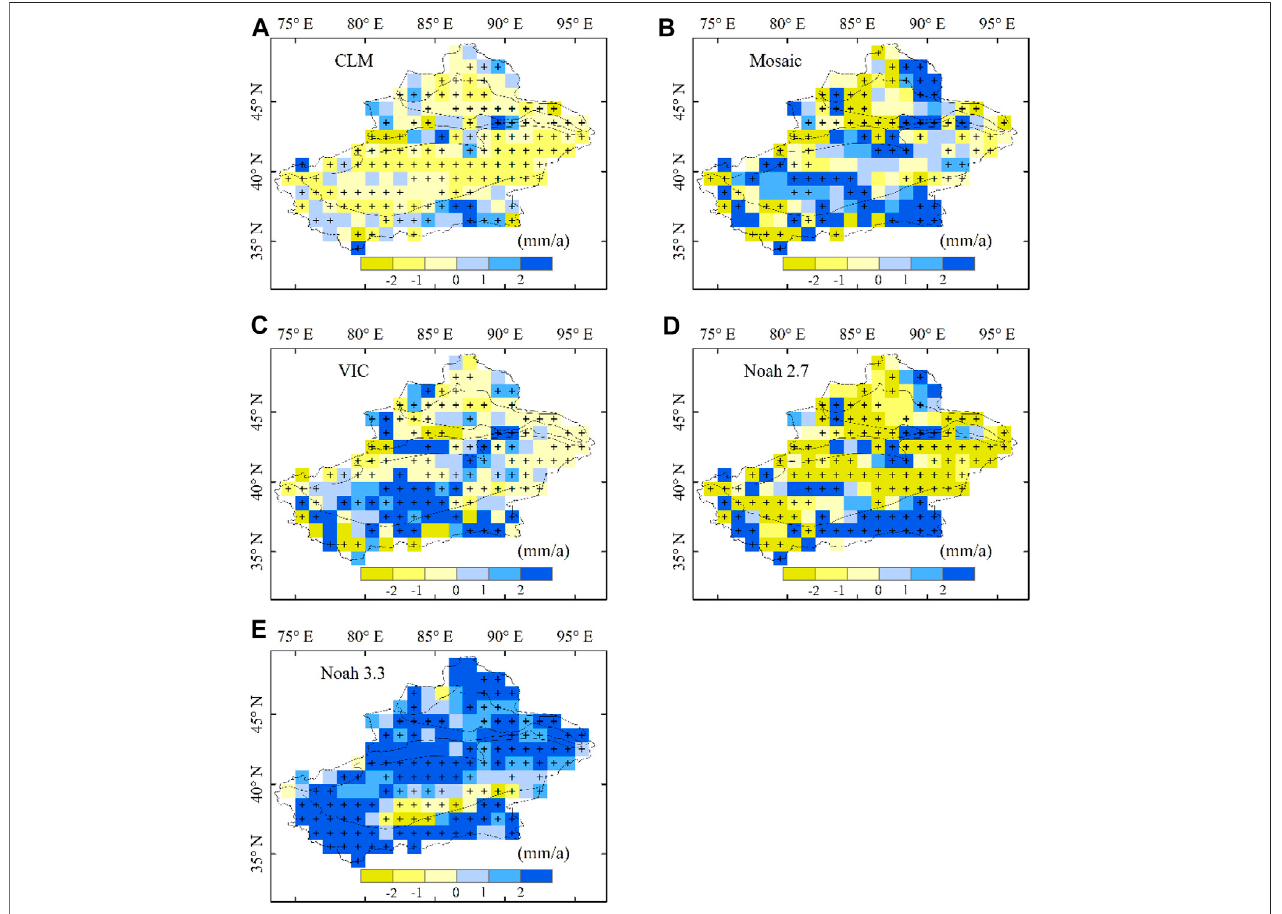
FIGURE 8 | Same as Figure 4 , but for SON soil